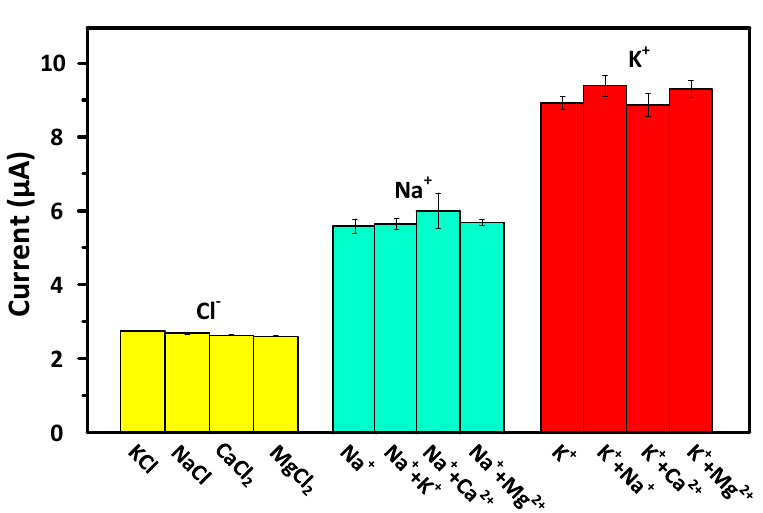
Figure 8. Interferences detection. Cl − detection: 100 mM KCl, 100 mM NaCl, 50 mM CaCl 2 , and 50 mM MgCl 2 ; Na + detection: 140 mM NaCl separately mixed with 4 mM KCl, 2.5 mM CaCl 2 , and 1 mM MgCl 2 ; K + detection: 4 mM KCl separately mixed with 140 mM NaCl, 2.5 mM CaCl 2 , and 1 mM MgCl 2 .